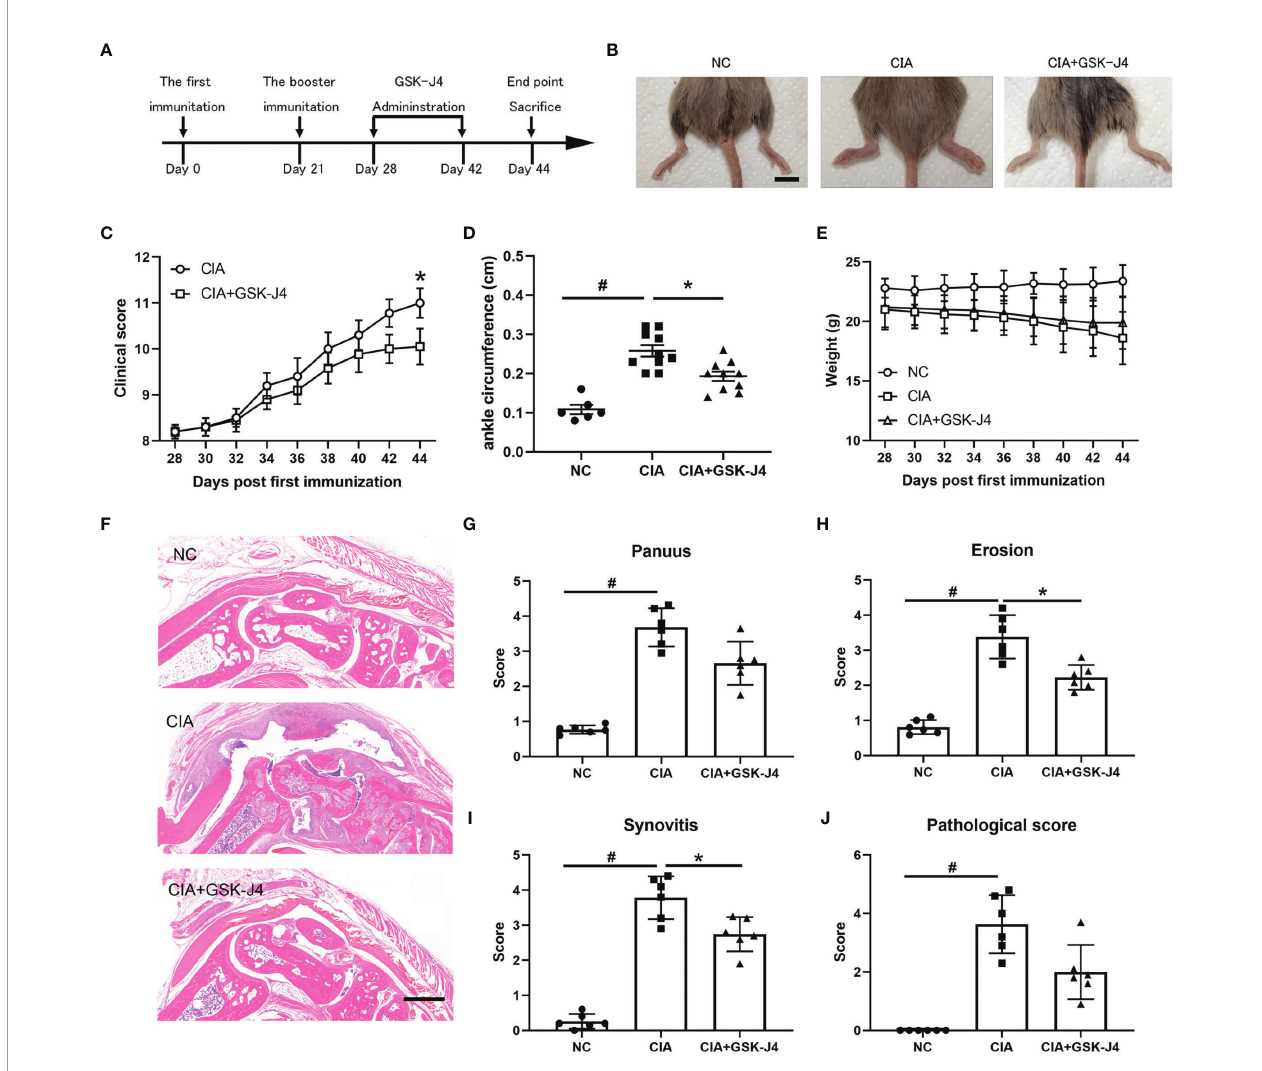
FIGURE 1 | Demethylase inhibitor GSK-J4 ameliorates collagen induced arthritis (CIA) in vivo. (A) The fl ow diagram of CIA model and GSK-J4 treatments. (B) Therapeutical effect of GSK-J4 on DBA1 mice. (C) According to joint swelling extend, scored 0~5 to all the paws. The scale bars represent 100 m m. (D) Ankle circumferences were measured at the 44th day. (E) Mice body weights were measured every two days after GSK-J4 administration. (F) HE staining of the hind legs of CIA mice, scale bar represents 100 m m. (G – I) Pathologic score of pannus, erosion and synovitis. (J) Pathological score of each given groups. p < 0.05 (two-tailed Student ’ s T-test) is indicated by * for comparison with CIA vs. CIA+GSK-J4, # for comparison with NC vs. CIA, error bars indicate